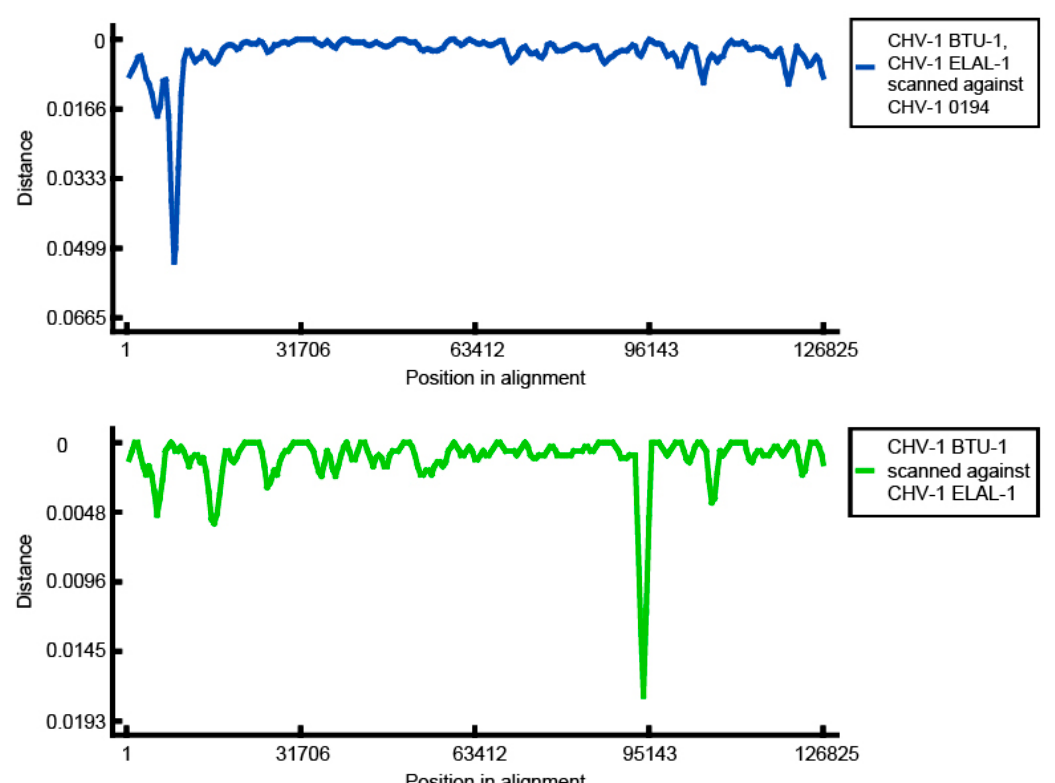
Figure 3. Genomic distance plotted against sequence position for CHV-1 isolates. An alignment containing 3 isolates (ELAL-1 (Clade 2), BTU-1 (Clade 2) and 0194 (Clade 1)) was processed in RDP4 ver 4.100. Results are for a manual distance plot with a window size of 1200, step size of 500 using the Jin and Nei model. The top graph (blue line) clearly illustrates a deep trough at approximately position 9kb in the alignment when either of the clade 2 isolates are scanned against the CHV-1 reference genome (0194, Clade 1). The bottom graph (green line) shows a deep trough at approximately position 93kb in the alignment when Clade A isolates are compared. This corresponds with the V57 gene region.